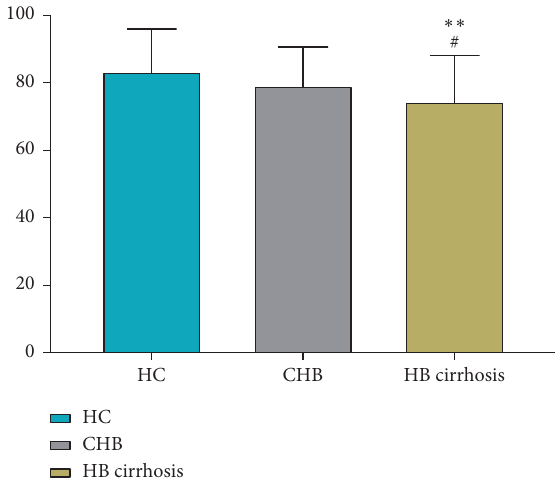
Figure 3: Comparison of CLDQ scores between HB groups. Compared with the CHB group, the HB cirrhosis group had significantly worse (# p < 0 . 05) emotional function and systemic symptom scores as well as significantly worse (## p < 0 . 05) total CLDQ, activity, and abdominal symptom